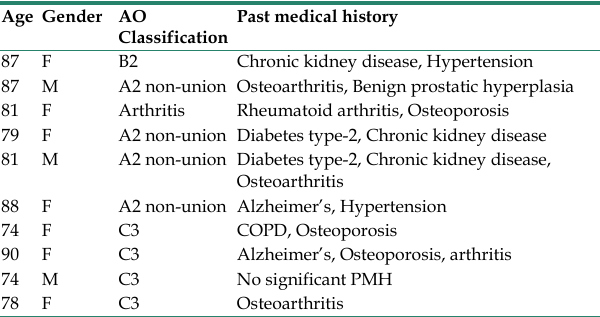
Table 1. Patients demographics